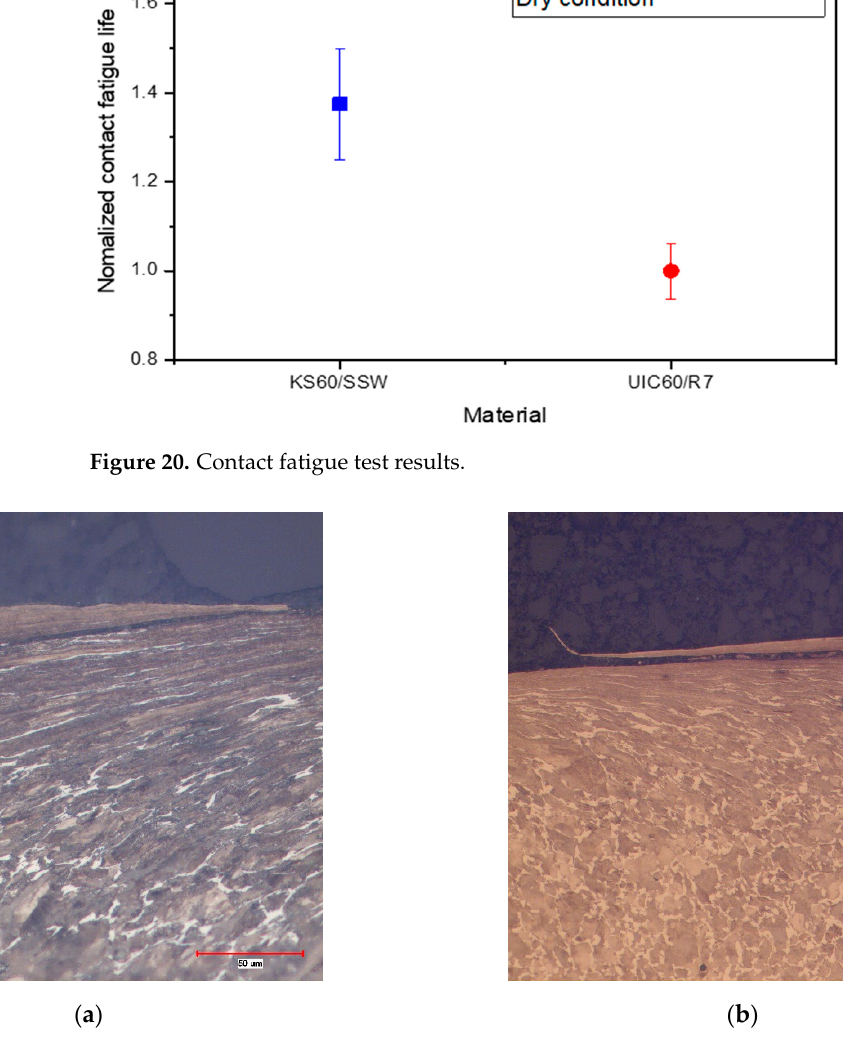
Figure 22. Comparison of fracture toughness and fatigue crack growth rate. ( a )